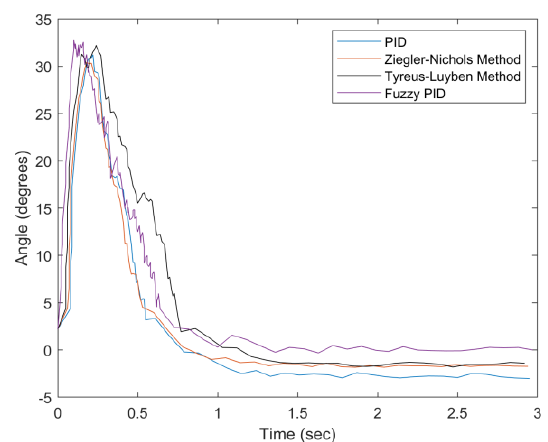
Figure 35. Tilt angle is approximately 25 degrees.